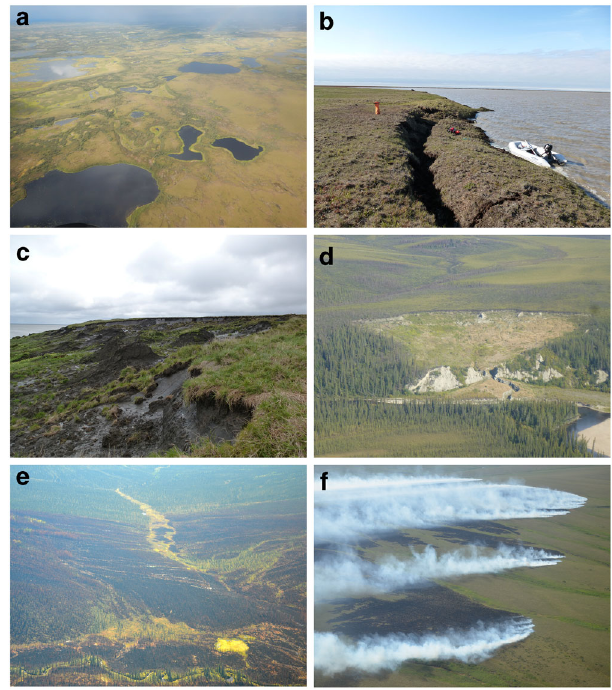
Fig. 2 Examples of key permafrost region disturbances. a Dynamic lake-rich region in western Alaska with frequent drainage, b Expanding thermokarst lake in northern Alaska, c Coastal retrogressive thaw slump on Bykovsky Peninsula in northeastern Siberia, d Selawik thaw slump in western Alaska, e Burn scar of wild fi re in boreal Alaska, and f Burning tundra fi re in northern Alaska. Photos taken by I. Nitze ( b − d ), B.M. Jones ( e , f ), and M. Fuchs ( a